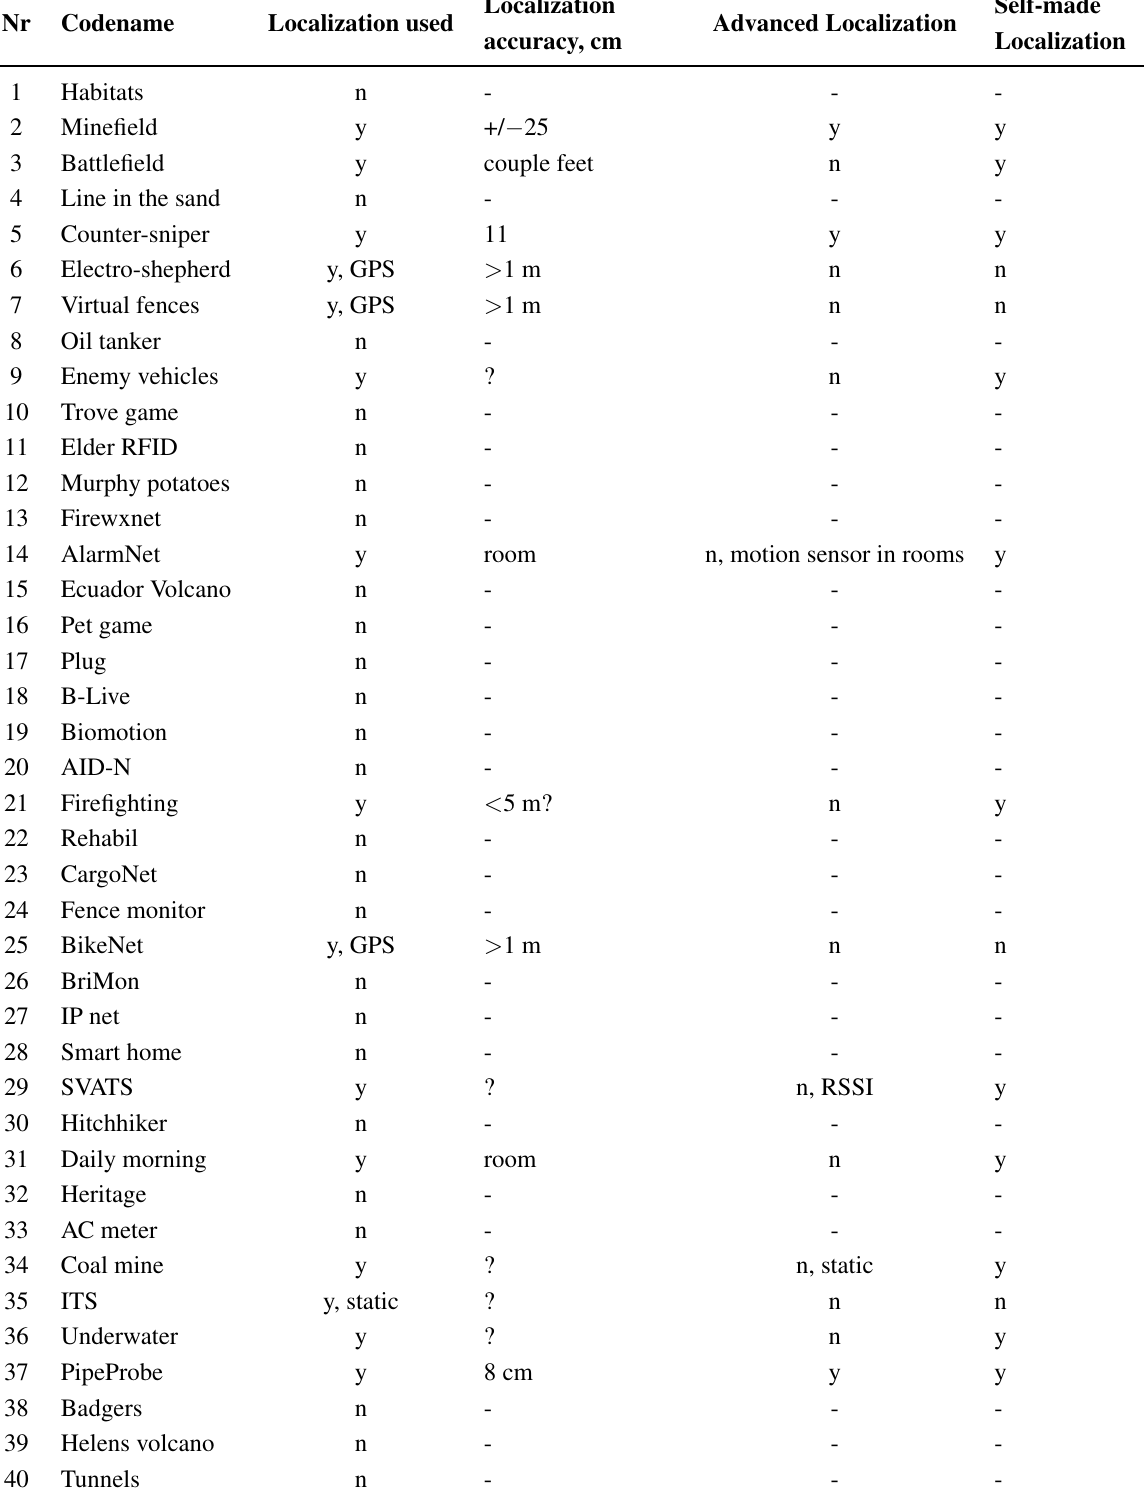
Table 17. Deployments: